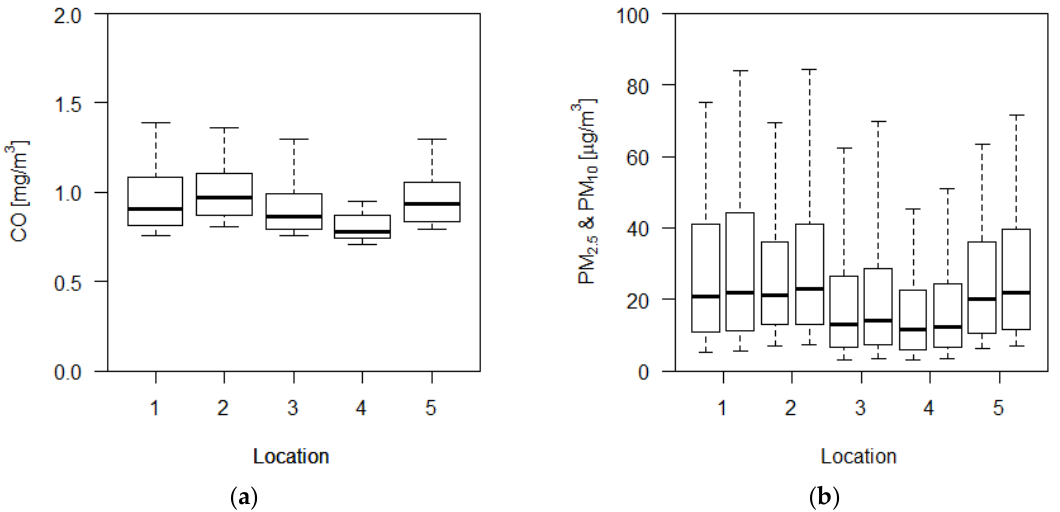
Figure 8. Boxplot for the hourly mean concentrations of: ( a ) CO, and ( b ) PM fractions (PM 2.5 on the left, PM 10 on the right side of the label) observed at each location in the analyzed period (box: 75th and 25th percentiles; whiskers: 10th and 90th percentiles; bold line: median). Figure generated using R